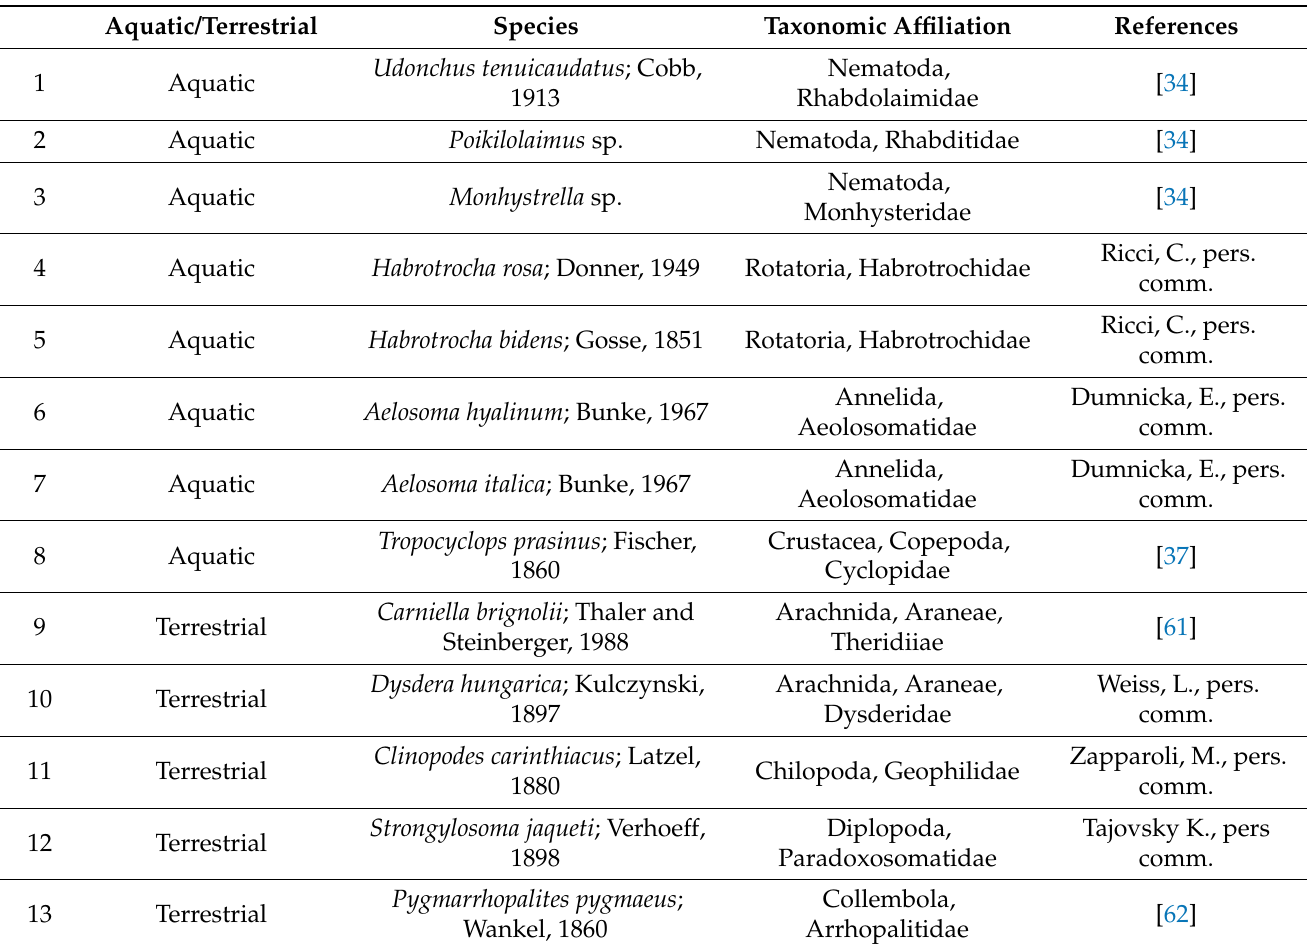
Table 3. List of troglophiles and stygophiles from Movile